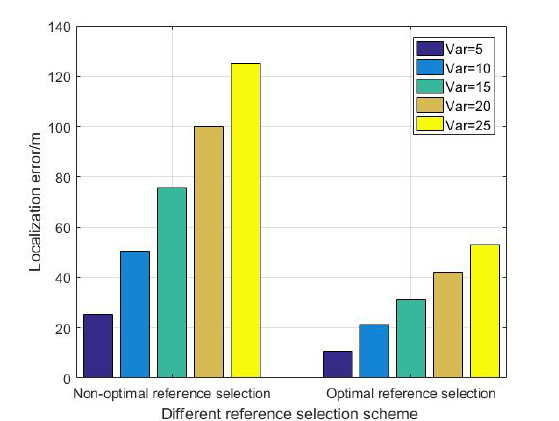
Figure 7. The Localization result of different reference selection.